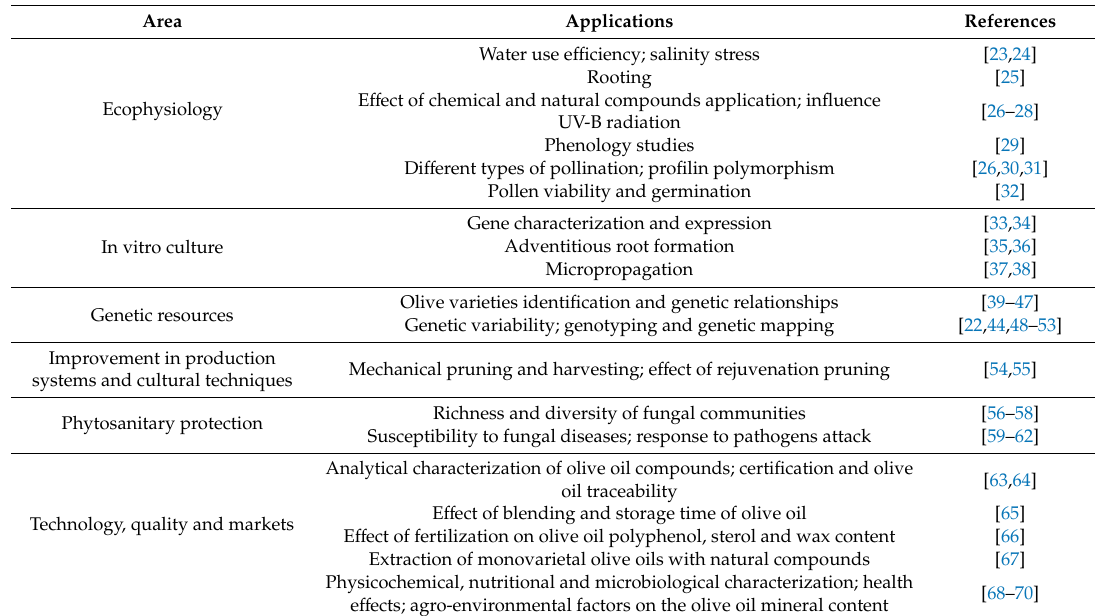
Table 1. Research developed considering the ‘Galega’ variety in the last years.